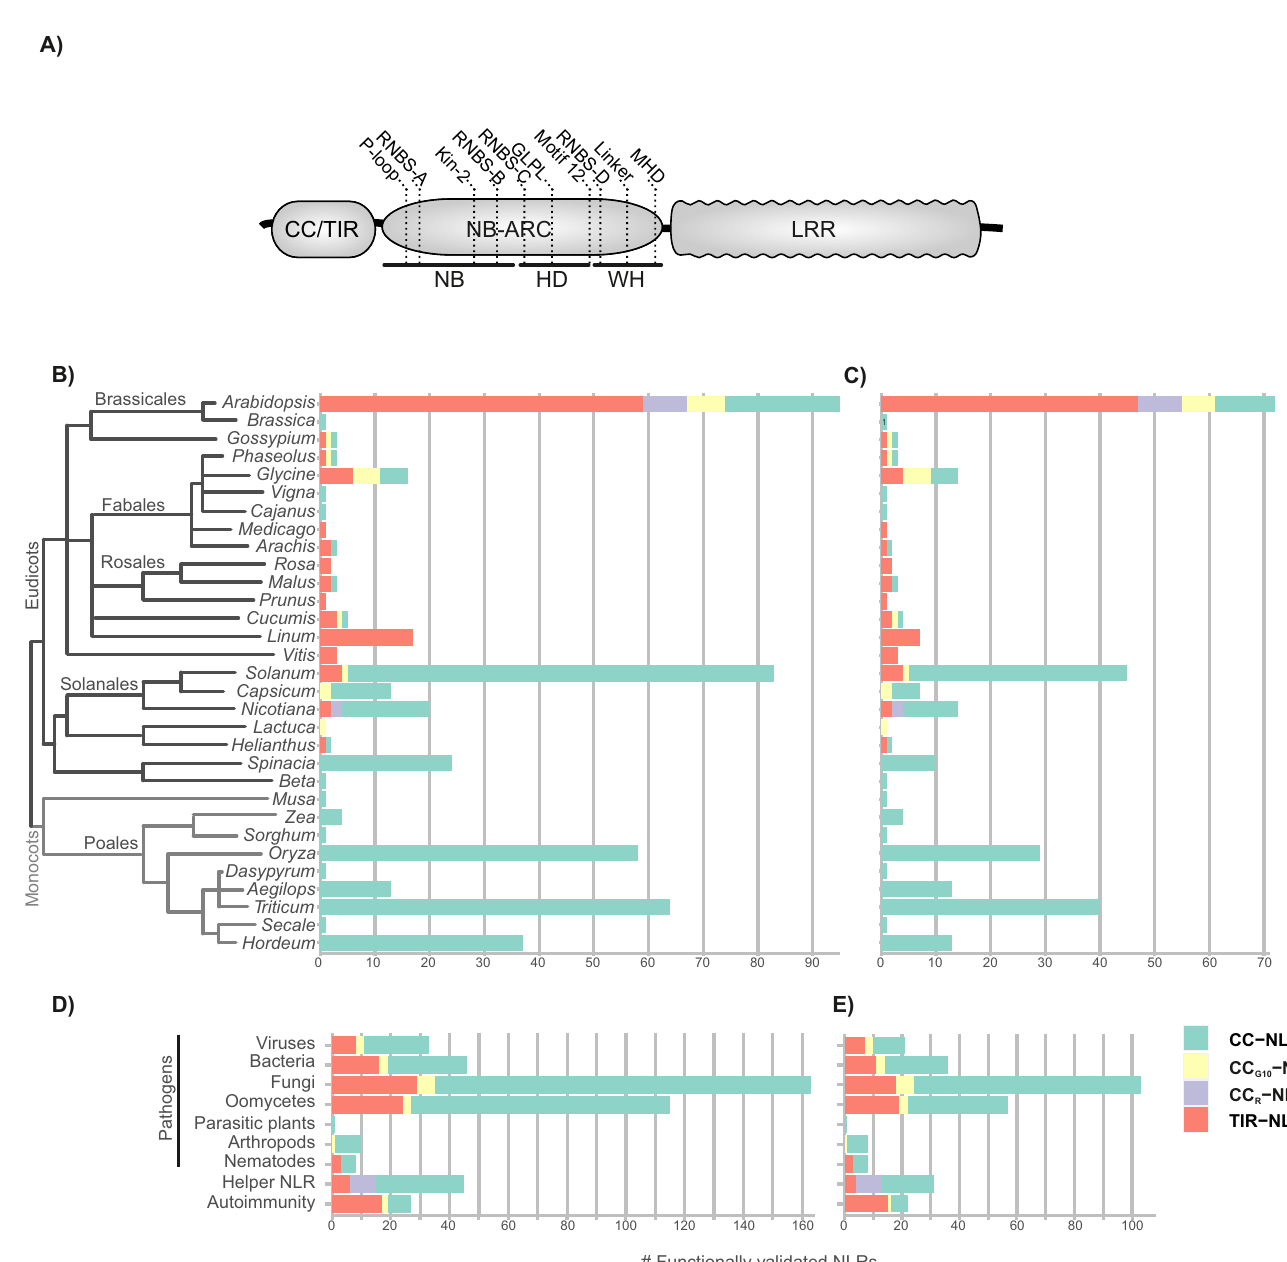
Fig 1. Number of experimentally validated RefPlantNLR sequences per plant genus. ( A) Domain architecture of typical plant NLRs. The structural features and conserved motifs of the NB-ARC are indicated. ( B) The number of experimentally validated NLRs per plant genus ( N = 481), and ( C) the per genus reduced redundancy set at a 90% sequence similarity threshold ( N = 303) are plotted as a stacked bar graph. ( D) The class of pathogen to which NLRs in the RefPlantNLR dataset confer a response. Some NLRs may be involved in the response against multiple classes of pathogens, while others have a helper role or are found to be involved in allelic variation in autoimmune/hybrid necrosis responses, and ( E) the per genus reduced redundancy set at a 90% sequence similarity threshold are plotted as a stacked bar graph. The number of experimentally validated NLRs belonging to the monophyletic TIR-NLR, CC-NLR, CC R -NLR, or CC G10 -NLR subclade members is indicated. Underlying data and R code to reproduce the figures in S5 Data . CC AU : AbbreviationlistsinFigs 1 (cid:0) 6 havebeenupdated : Pleaseverifythatallentriesarecorrect : , coiled-coil; HD, helical domain of apoptotic protease- activating factors; LRR, leucine-rich repeat; NB, P-loop containing NTPase domain; NLR, nucleotide-binding leucine-rich repeat; TIR, Toll/interleukin-1 receptor; WD, winged helix